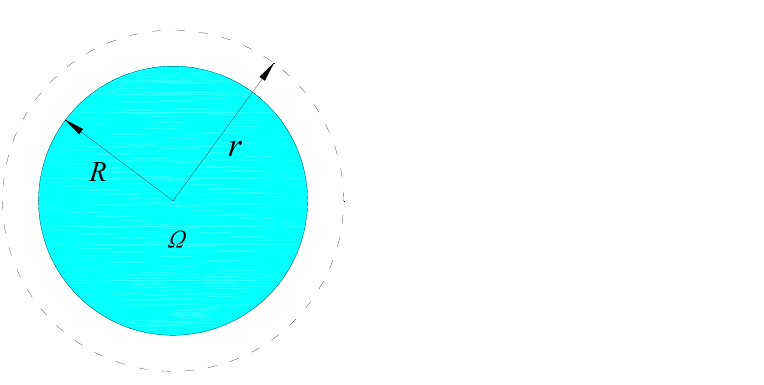
Figure 3. Discretization of the axial compression on the part boundary of the circular shaft.